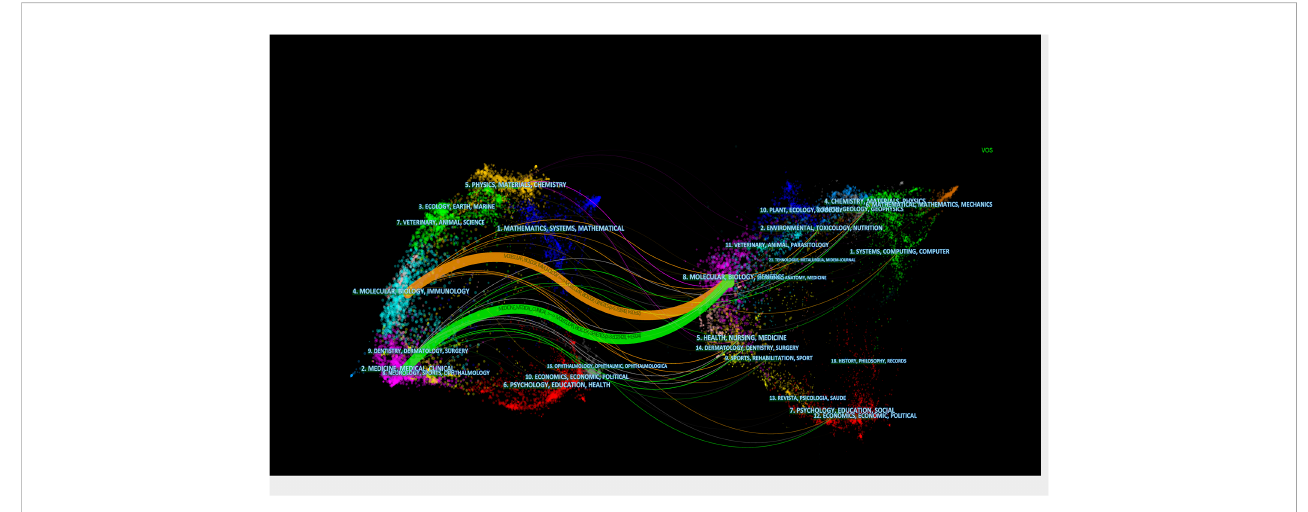
FIGURE 4 Dual-map overlay includes HNSCC immunotherapy-related